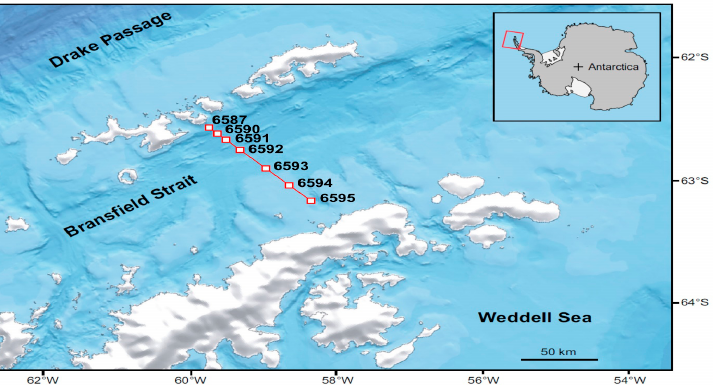
Figure 2. Locations of oceanographic stations in the Bransfield Strait (79th cruise of R/V “Akademik Mstislav Keldysh”, January 2020) where bacterioplankton samples were collected at 5 to 7 depths in austral mid-summer.